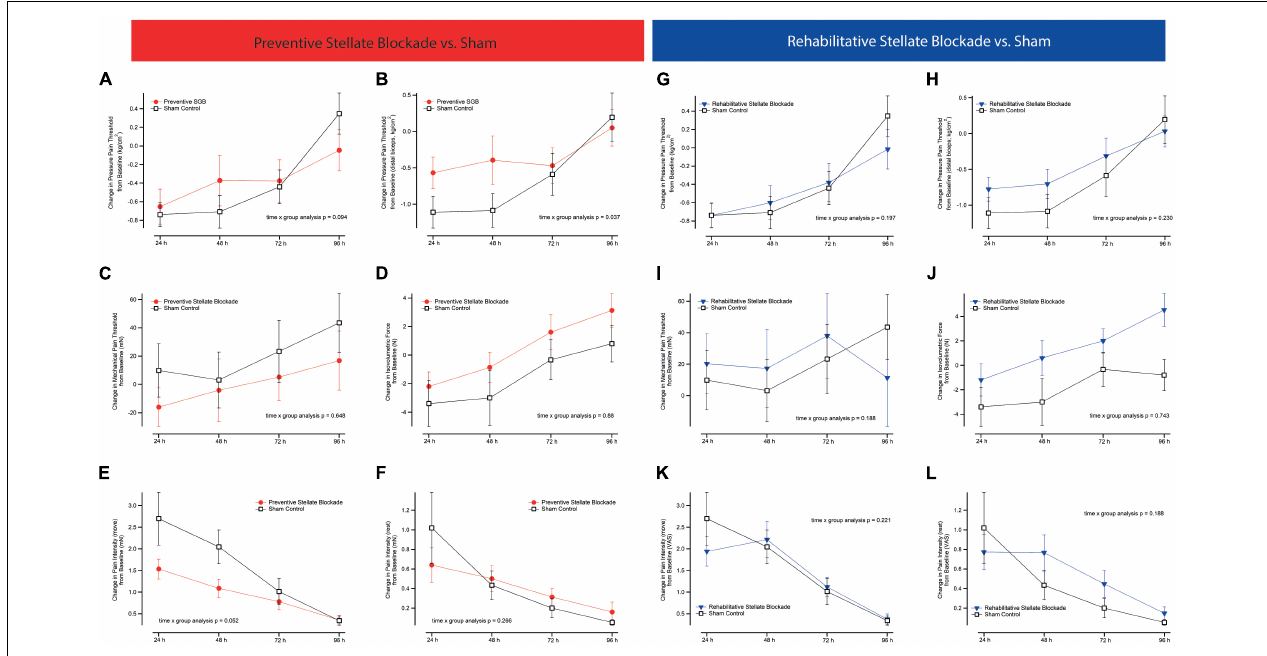
FIGURE 2 | Pain outcomes. Figures comparing changes in functional and pain related outcomes between either preventive or rehabilitative SGB, and sham control. (A,G) Overall pressure pain threshold (PPT) as the mean of five measures equidistant along the upper biceps muscle, (B,H) PPT above the distant belly of the biceps muscle, (C,I) mechanical pain threshold, (D,J) maximum isovolumetric force of the biceps muscle, (E,K) pain intensity of the biceps muscle whilst bending the arm, (F,L) pain intensity of the upper arm at rest. All analyses are time x group analysis indicating between group changes over time. Data are presented as mean ± SEM.